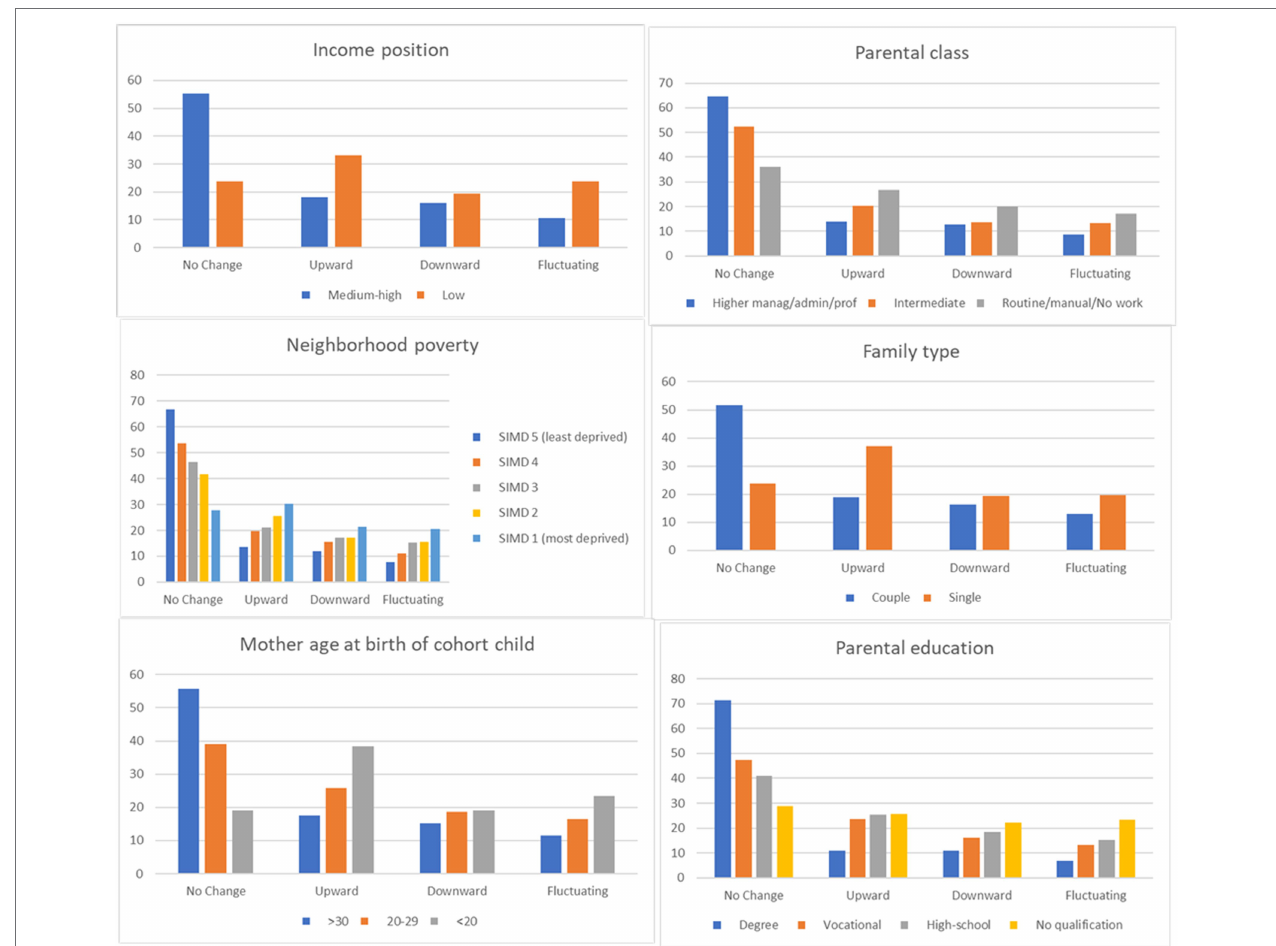
FIGURE 1 | Social demographic profiles of families by forms of income volatility